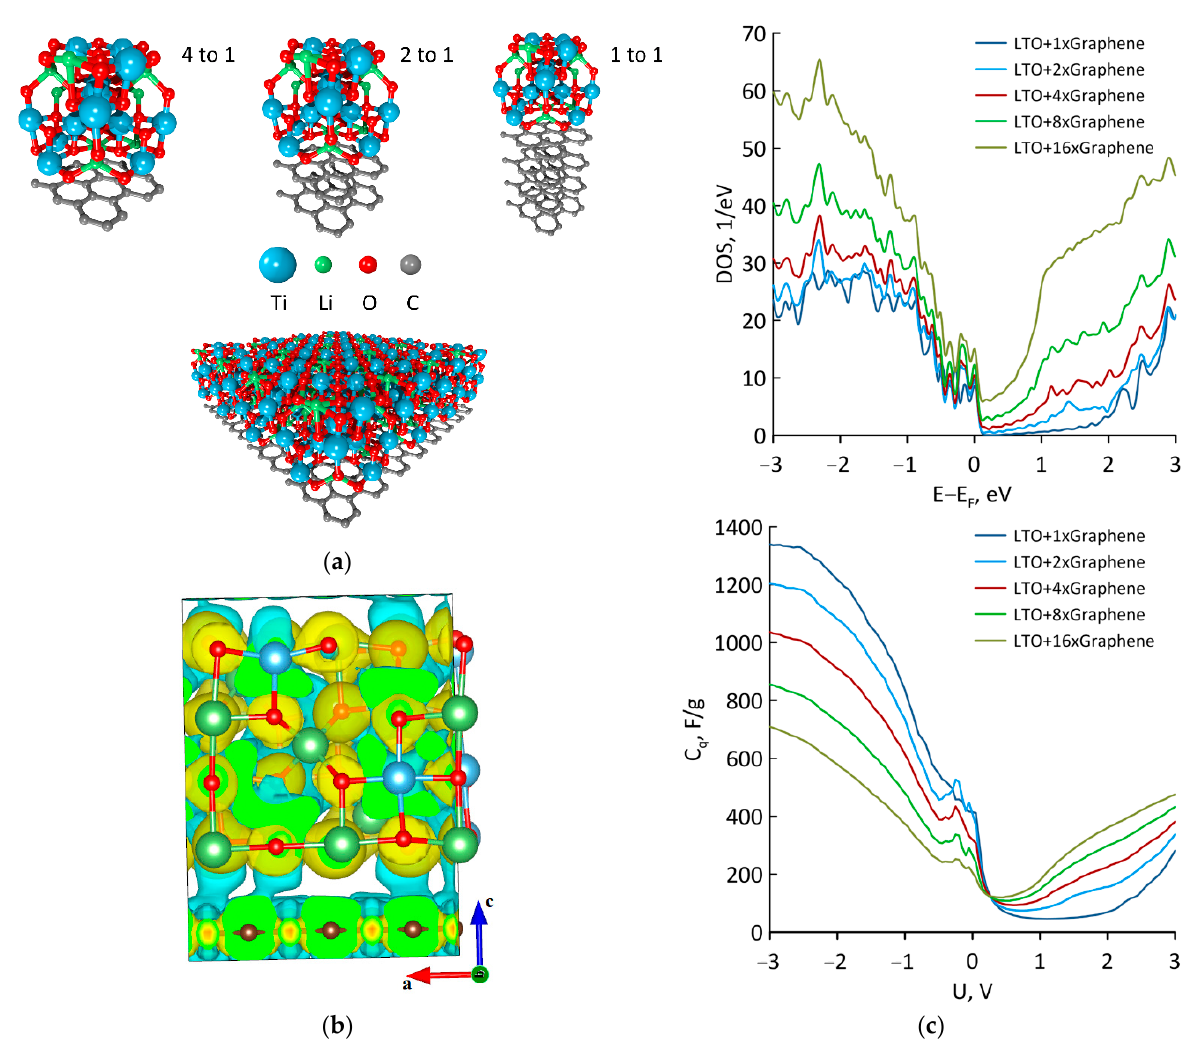
Figure 3. G/LTO nanocomposites: ( a ) the supercells of G/LTO with m(LTO):m(G) 4:1; 2:1 and 1:1 and the expanded 4:1 supercell; ( b ) volumetric data for charge distributions or wave functions; ( c ) DOS and QC plots. Table 1. Electronic and energetic properties of G/LTO composites with different mass ratios. Approximate Mass Structure Ration m(LTO):